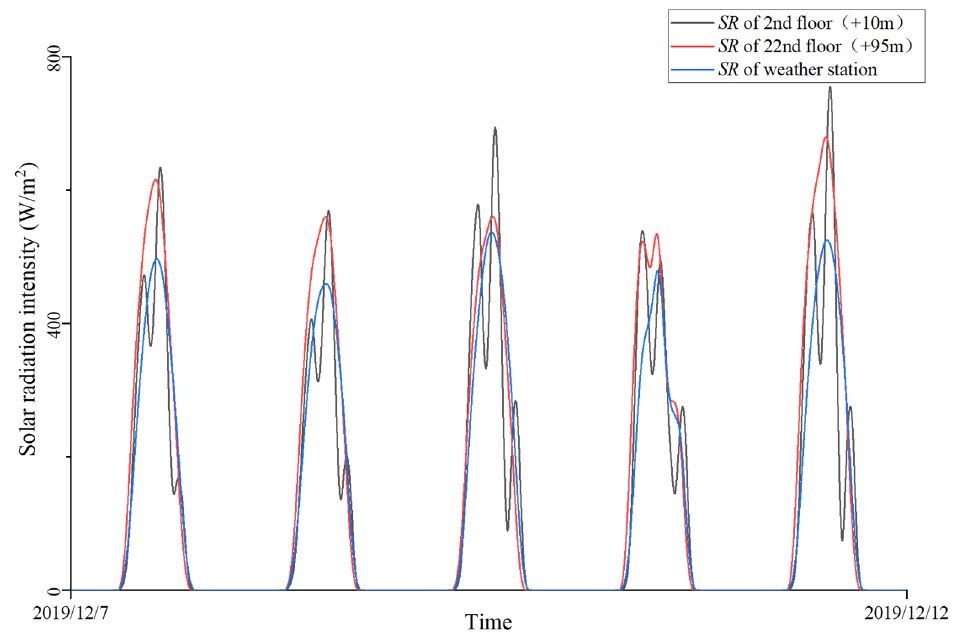
Figure 5. Solar radiance on the vertical wall of a high-rise building (without group shadow).